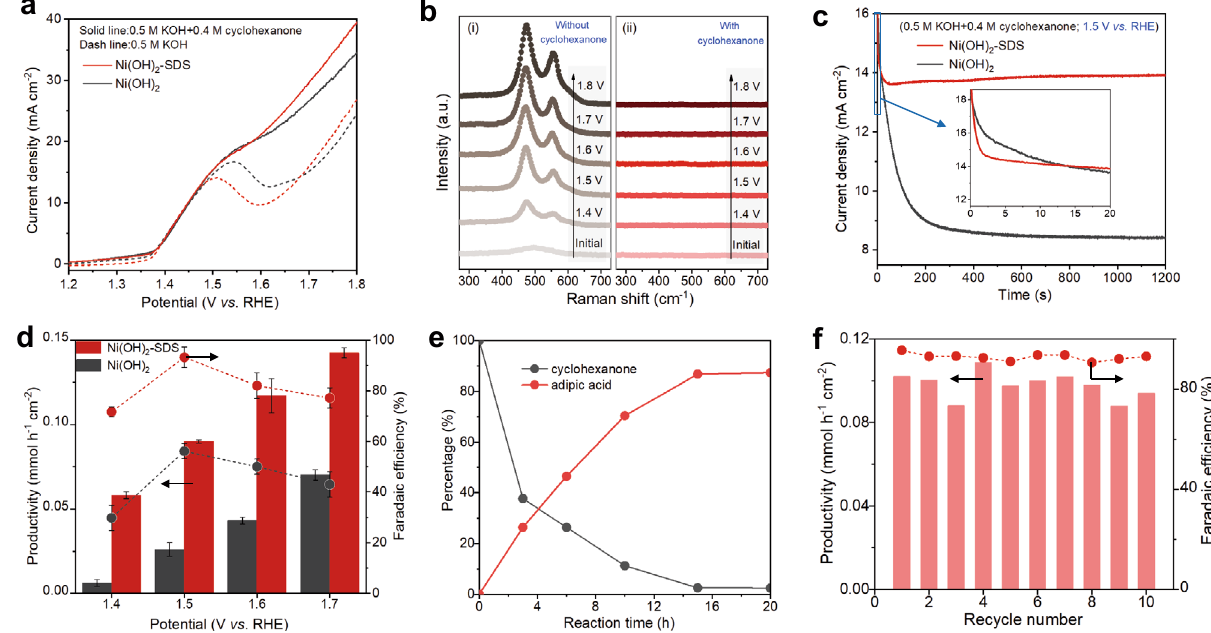
Fig. 3 | Cyclohexanone elelctrooxidation over Ni(OH) 2 and Ni(OH) 2 -SDS cata- lysts.a LSVcurvesofNifoamsupportedNi(OH) 2 -SDSandpureNi(OH) 2 catalystsat scanrate of 10mVs − 1 . b InsituRaman spectraofNi(OH) 2 -SDSin0.5MKOHwithor without cyclohexanone. a.u.: arbitrary units. c I - t curves of Ni(OH) 2 -SDS and pure Ni(OH) 2 . d Adipic acid productivity and FE over Ni(OH) 2 -SDS and pure Ni(OH) 2 at different potentials. The error bars represent the standard deviation of